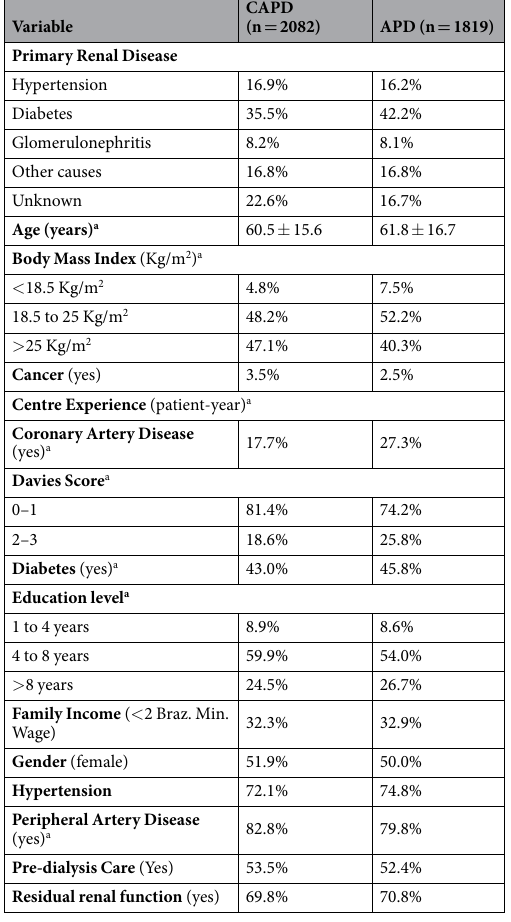
Table 2. Clinical and demographic characteristics according to initial PD modality. Legend: a p <